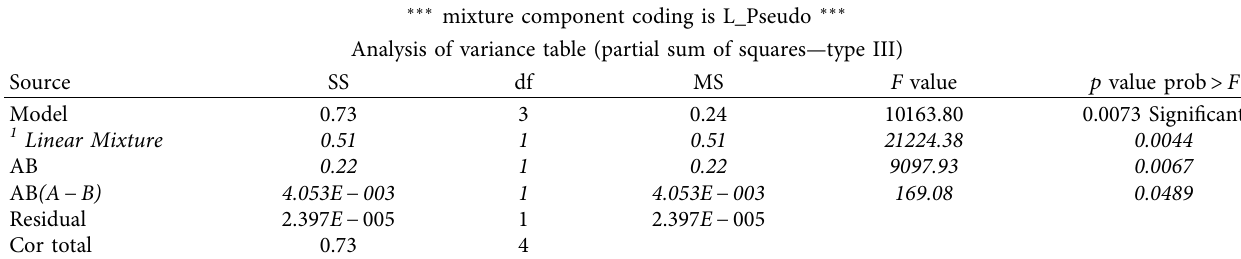
Figure 16: Ramps graph for the desirability function. Table 15: ANOVA cubic mixture model for compressive strength response.